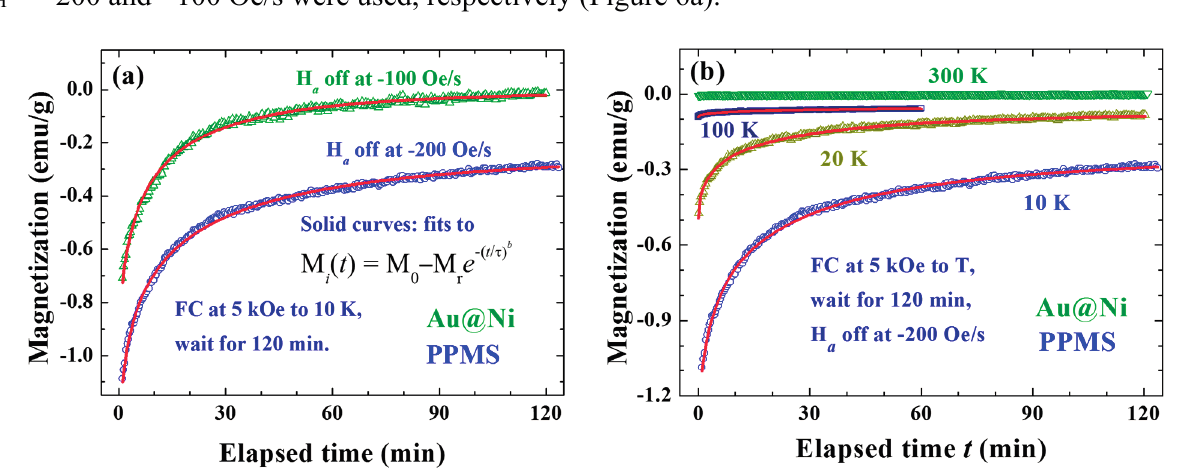
Figure 6. ( a ) Temporal evolution of the magnetization recorded after field-cooling at H a = 5 kOe from 300 to 10 K, followed by waiting for 120 min before turning the H a off at rates of − 200 Oe/s (open circles) and − 100 Oe/s (open triangles); and ( b ) temporal evolution of the magnetization recorded after field-cooling at H a = 5 kOe from 300 K to four representative temperatures, followed by waiting for 120 min before turning the H a off at a rate of − 200 Oe/s. The solid lines indicate the fits of the data to the exponential profile listed in ( a